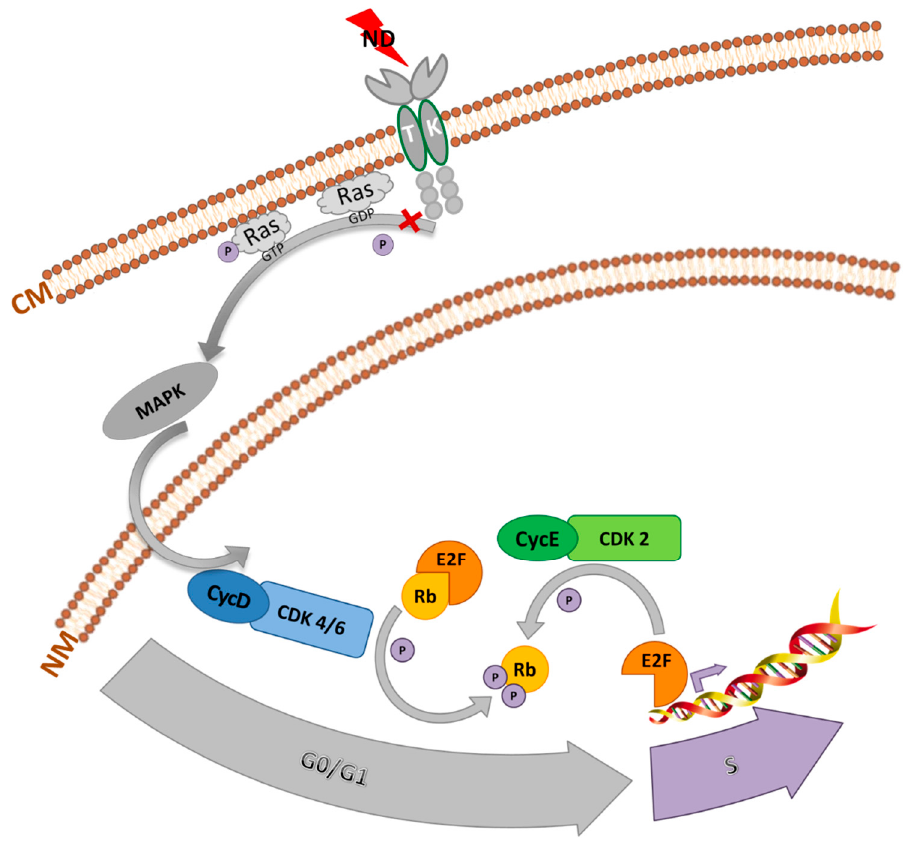
Figure 9. Proposed mechanism of antiproliferative action of diamond nanoparticles.